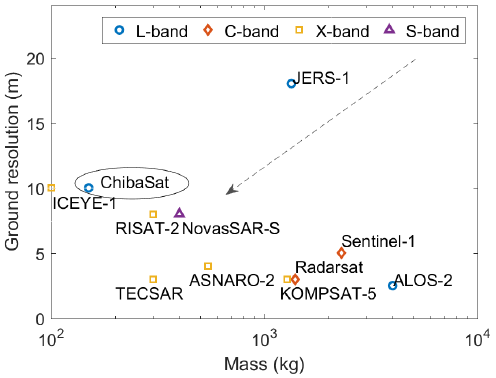
Figure 1. Trends in miniaturization of past, current and future spaceborne SAR missions: spacecraft mass = − 20 versus range resolution for σ 0 NE